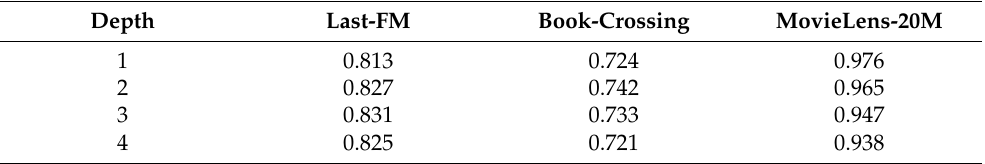
Table 6. Influence of different propagation depths on the AUC. Depth